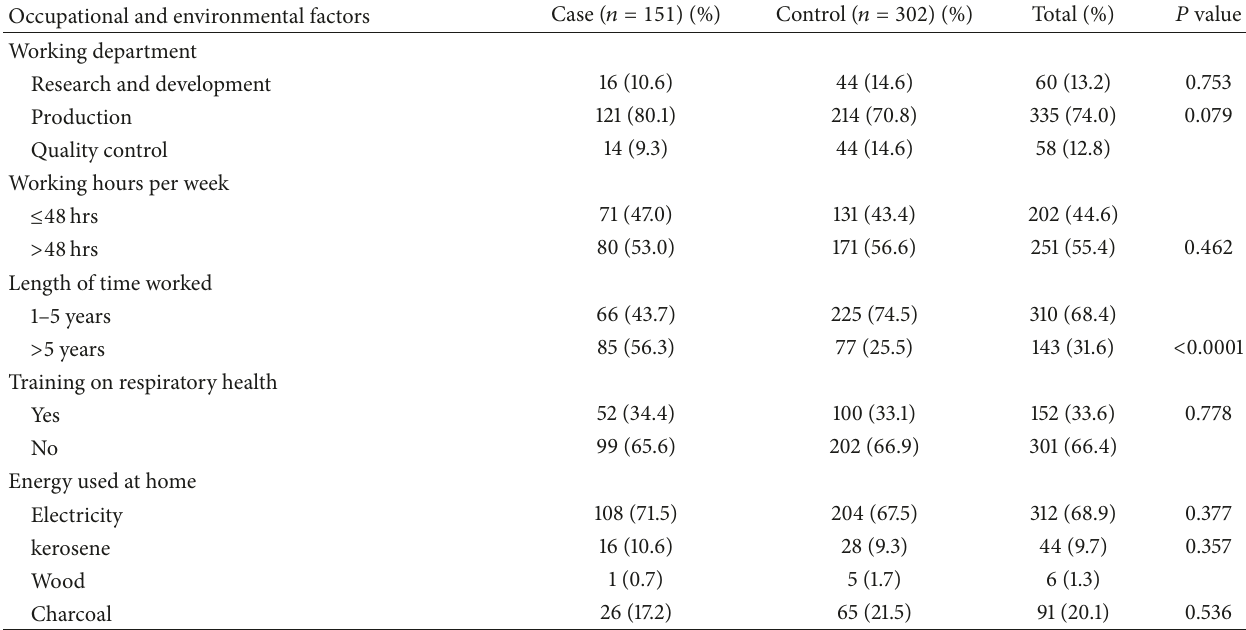
Table 4: Distribution of occupational and environmental factors of participants in pharmaceutical factories in Addis Ababa, Ethiopia, May